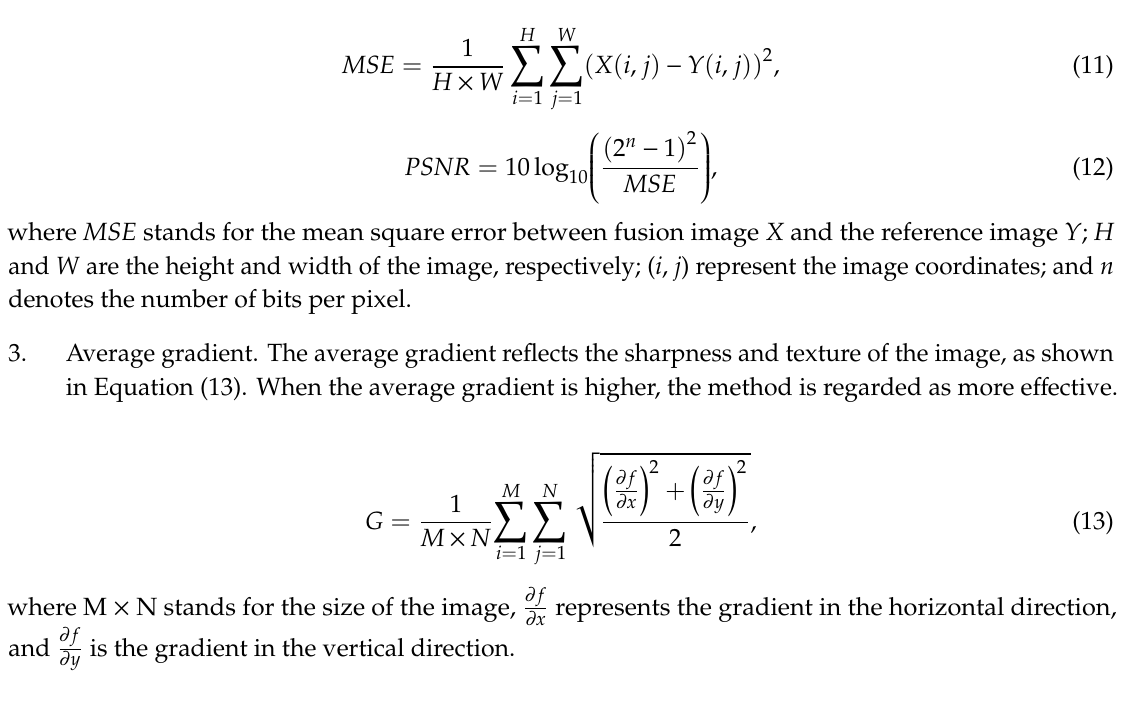
Figure 10. Comparison with other methods. ( a )–( d ) The multi-exposure raw image sequence. ( e ) The result using the tone mapping method of Drago [28]. ( f ) The result using the tone mapping method of Mantiuk [26]. ( g ) The result using the tone mapping method of Reinhard [25]. ( h ) The traditional direct fusion result with JPEG. ( i ) The JPEG image fusion result using our method; ( j ) Our method with raw images.